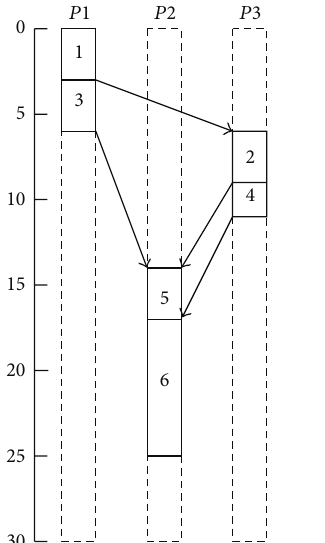
Figure 6: Schedule obtained by HEFT.